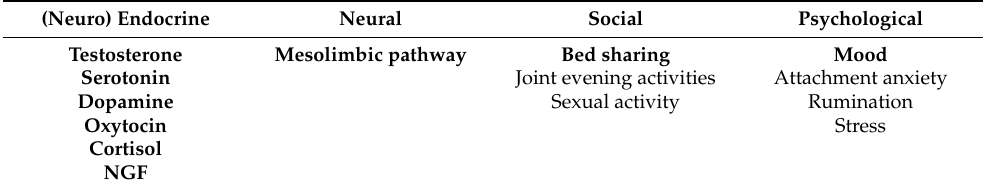
Table 2. Mechanisms that might cause sleep variations in people experiencing romantic